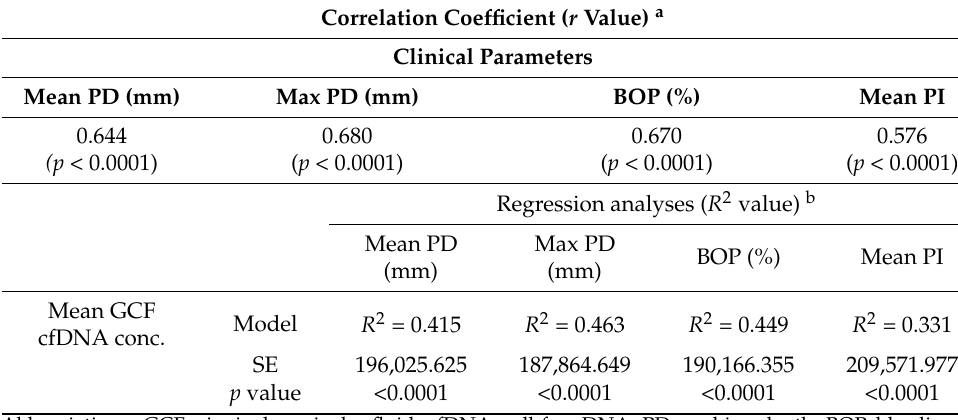
Table 2. Correlations between GCF cfDNA concentration and clinical parameters.